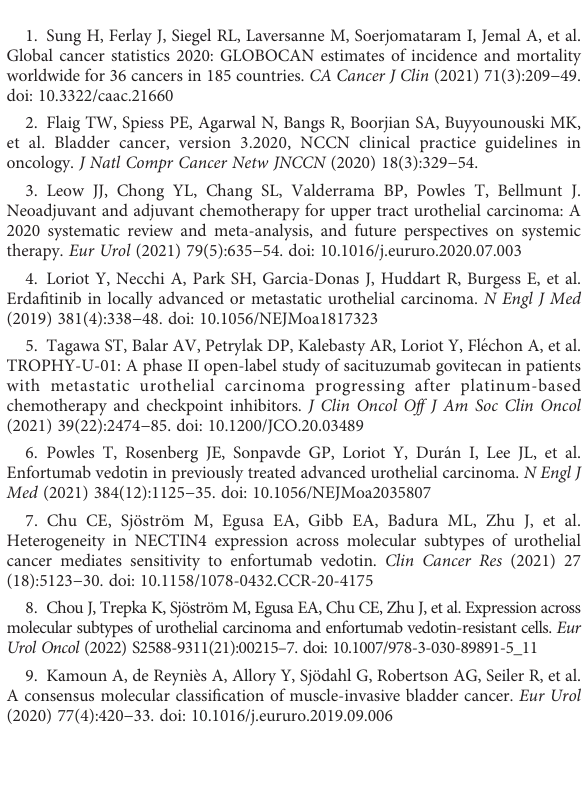
SUPPLEMENTARY TABLE 1 Clinical and histological characteristics of patient tumors and matched PDXs. SUPPLEMENTARY TABLE 2 Short Tandem repeat (STR) pro fi ling of patient tumors and matched PDX(s). SUPPLEMENTARY TABLE 3 List of the sequenced genes in the next-generation targeted sequencing panel. SUPPLEMENTARY TABLE 4 Next-generation sequencing results (mutations, copy number alterations, microsatellite status and tumor mutational